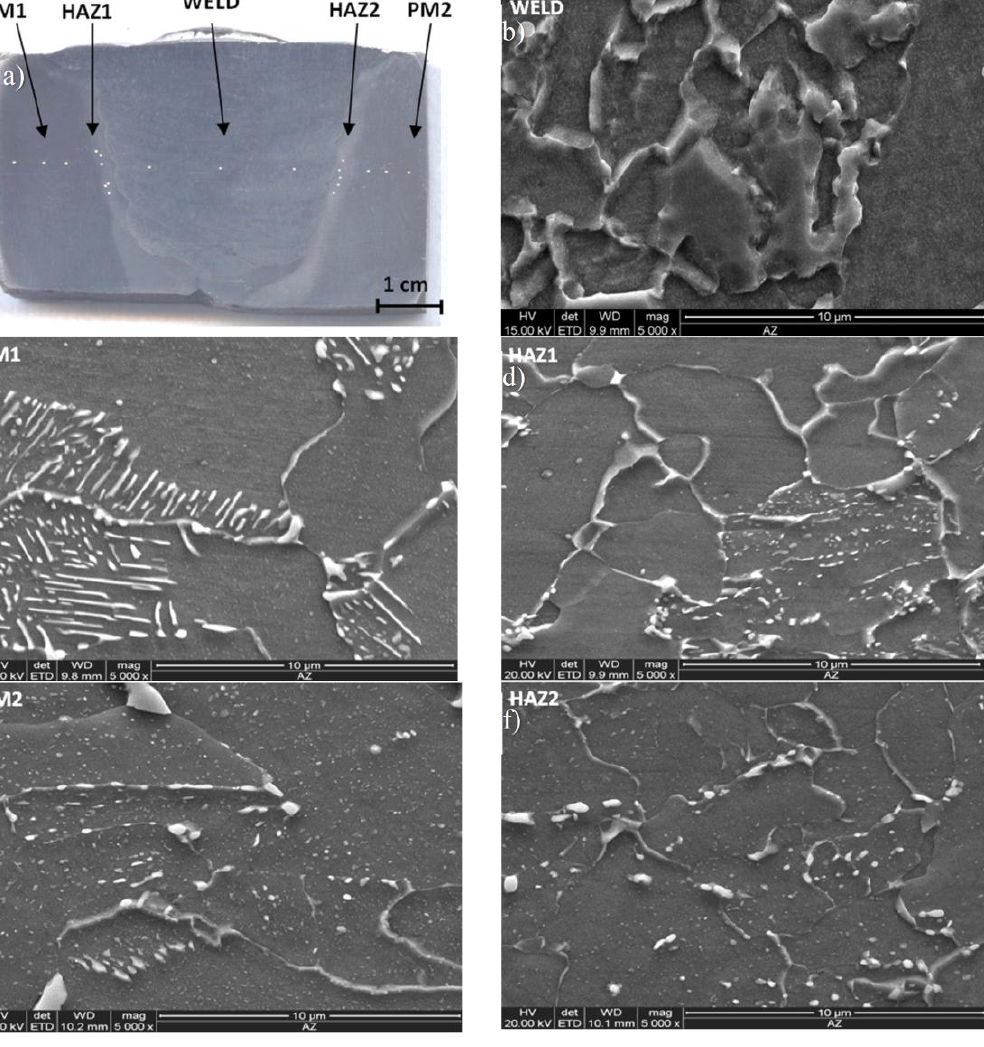
Figure 4. Structure of the material of components of the repair welded joint marked ZS2 made from 14MoV6-3 steel in the as-received condition and after 169,000 h service; investigation performance locations ( a ): parent material marked ( c ) PM1, ( e ) PM2; heat affected zone marked ( d ) HAZ1, ( f ) HAZ2; weld marked ( b ) WELD. Table 3. Review of the results of microstructure investigations and hardness tests on the material of components of repair welded joints. Figure Description of Microstructure Material Hardness No. Condition—Exhaustion Degree HV10 Ferritic-bainitic structure. No discontinuities or micro-cracks are observed in the structure. Figure 3